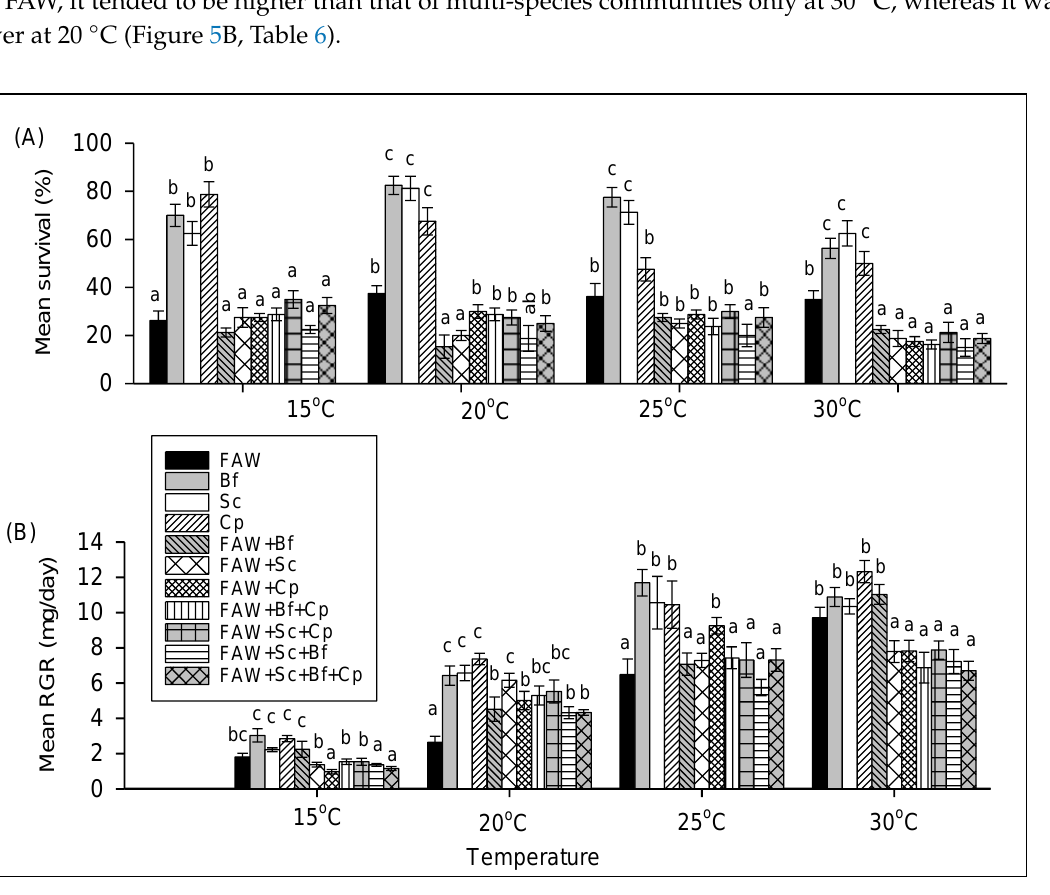
Figure 5. Comparison of survival ( A ) and relative growth rate ( B ) between single-species and multi-species combinations of S. frugiperda (FAW), B. fusca (Bf), S. calamistis (Sc), and C. partellus (Cp) under different constant temperatures. Statistical comparisons were only made between single- and corresponding multi-species pairings (see Tables 5 and 6). Means (±SE) were compared using Tukey’s multiple comparisons tests performed using with lsmeans R package [21], following generalized linear model (GLM) with simple binomial procedure for survival or false discovery rate [22] following analysis of variance (ANOVA) after constructing general linear models for relative growth rates.